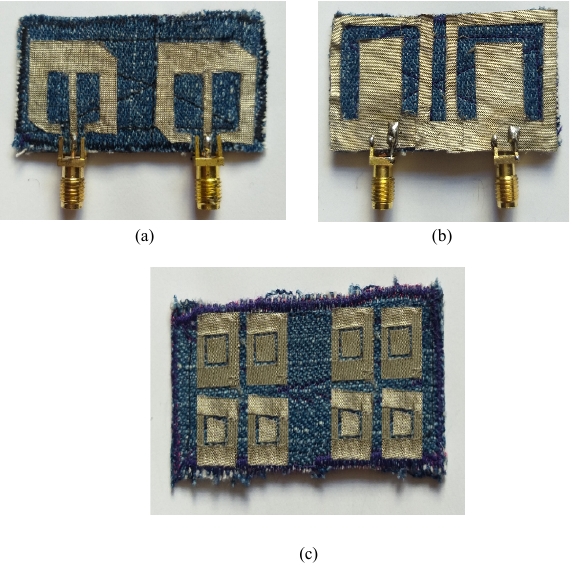
FIGURE 4. Fabricated fabric CP-MIMO antenna (a) Top view (b) Bottom view